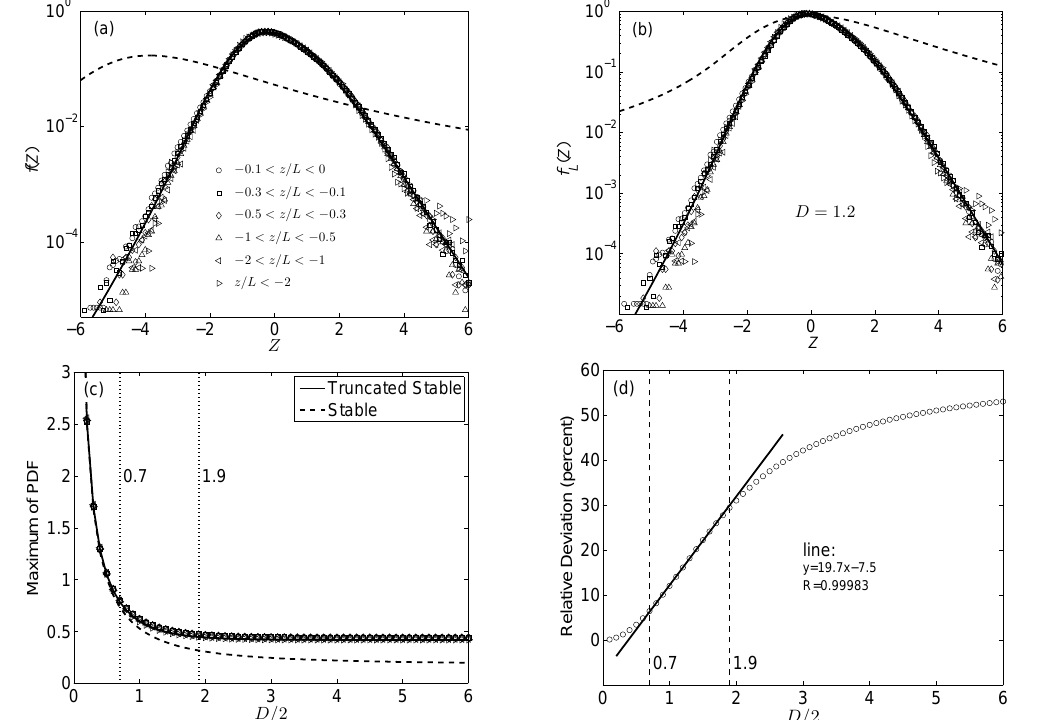
Fig. 2. Defining threshold in the time series of dimensionless vertical velocity fluctuations. (a) Comparison between observed PDFs and the reference distribution. Different points denote the observed PDFs under different stability conditions. The observed PDFs can be well fitted by the truncated stable distribution (shown by the line). The stable distribution as the reference PDF is shown by the dashed line. (b) Comparison between observed and reference PDFs which are already normalized in the ranges of [ − 0 . 15 − 0 . 6 , − 0 . 15+0 . 6] and [ − 3 . 85 − 0 . 6 , − 3 . 85+ 0 . 6] respectively. (c) Variations of maxima of partly normalized PDFs as a function of D/ 2 . Different symbols represent different stability ranges which are the same as those in (a). Maxima of partly normalized stable and truncated stable PDFs are denoted by the line and the dashed line respectively. (d) Variations of absolute values of relative deviation between maxima of partly normalized stable and truncated stable PDFs as a function of D/ 2 . Regions are marked out by the dashed lines and the positions of these lines on x-axis are also shown in this plot. The same dividing lines and corresponding positions are also marked in (c) by dotted lines.